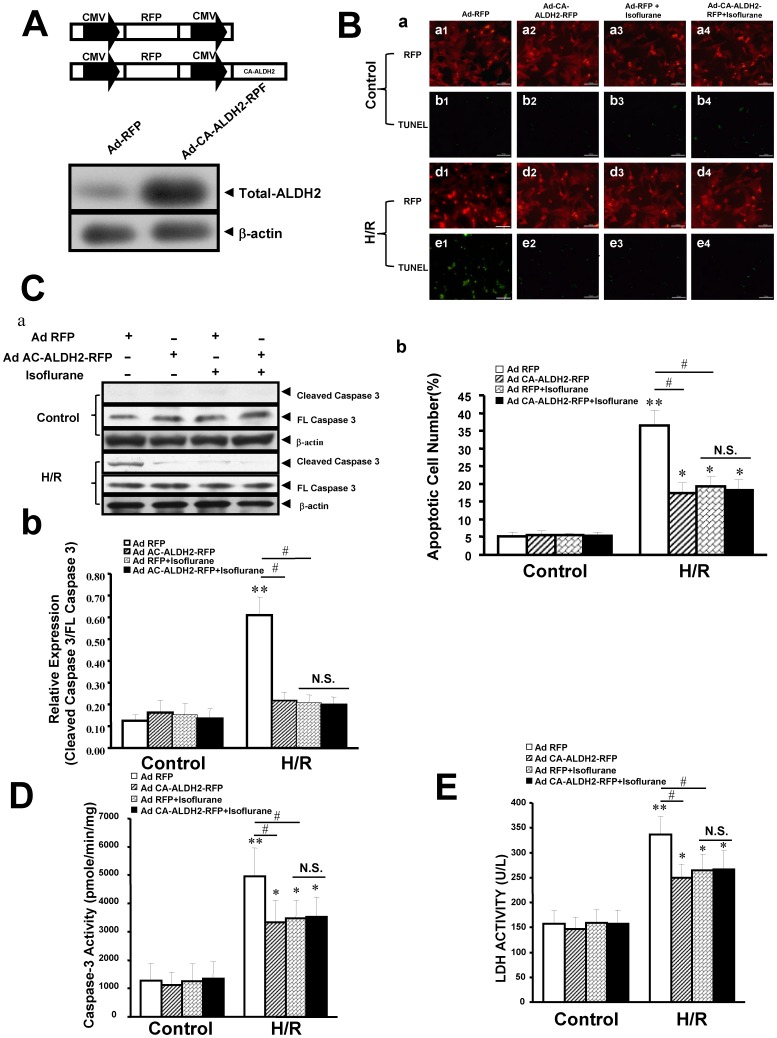
ALDH2 activation induced protection against hypoxia/reoxygenation.A. Schematic representation of adenoviruses encoding RFP (Ad-RFP) and CA-ALDH2 (Ad-CA-ALDH2-RFP, left panel); right panel, immunoblotting analysis of ALDH2 protein level. β-actin was used as a control. B. Expression of constitutively active mutant of ALDH2 attenuated TUNEL positive staining level, which was not reinforced by isoflurane. (a) Apoptotic cells were examined using TUNEL assay for DNA fragmentation. Cardiomyoctes were photographed by fluorescence microscopy after 24 hours of hypoxia followed by 12 hours of reoxygenation. TUNEL-positive nuclei are shown in green and transfection efficiency of adenoviruses in red. (b) Quantitative analysis (percentage of apoptotic cells versus total) is shown in histogram. C. Representative Western blots of cleaved caspase-3 and FL caspase-3 in (a), and 3 independent experiments are quantitated in (b). β-actin was used as a loading control. D. Cell lysates under each condition were quantitatively assayed for caspase-3 activity. E. LDH concentrations in cell culture media were analyzed. Values are means ± S.E.M., n = 5 in each group. *P<0.05, **P<0.01 vs. Control group, and #P<0.05 vs. the corresponding Ad-RFP group.